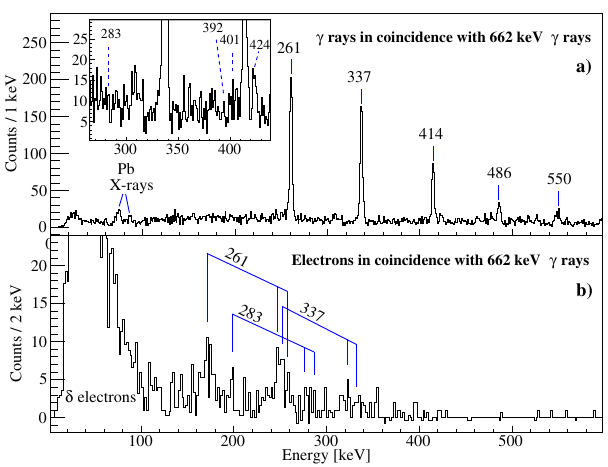
Fig. 6 Evidence for the highly-converted 2 þ gated, α -tagged γ -ray ( a ) and electron ( b ) energy spectra in coincidence with 662 keV γ rays. The most prominent peaks have been labelled with corresponding transition energies and positions of the K-, L- and M-conversion components are marked.